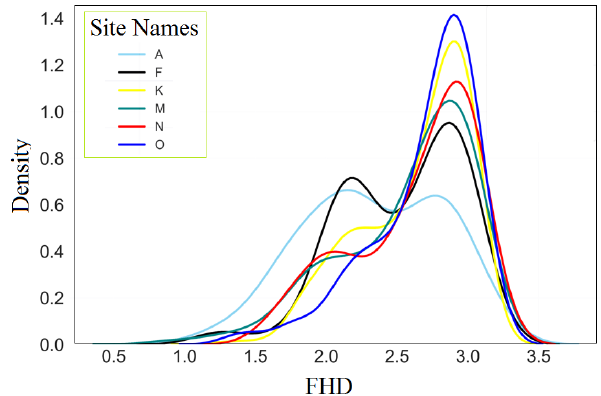
Figure B3. FHD distribution for each site.